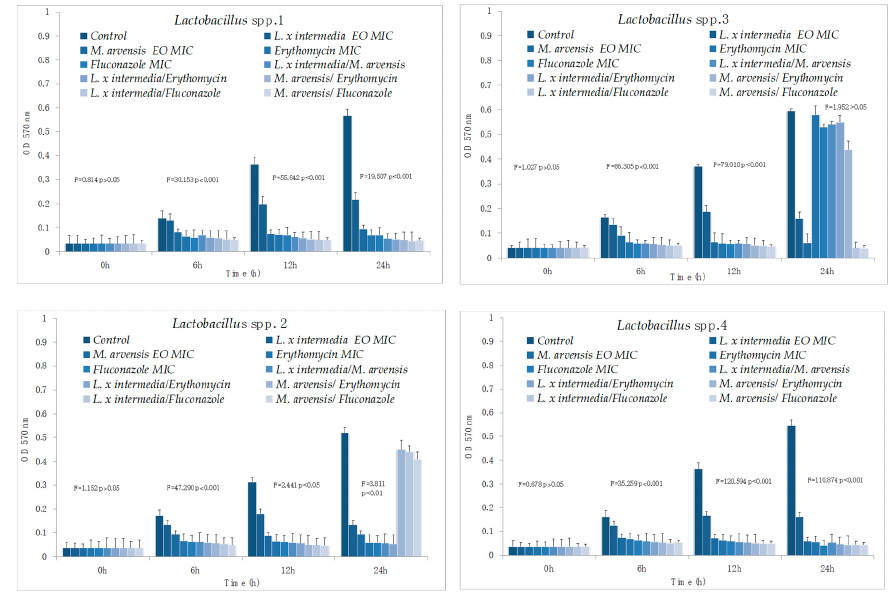
Figure 2. Time–kill studies of L. x intermedia, M. arvensis EOs, antimicrobials (erythromycin and fluconazole), and of different combinations (antimicrobial/EO and EO/EO) against Lactobacillus spp. strains. p -values of < 0.05, p < 0.01, p < 0.001 and p < 0.0001 were considered significant by t -test and